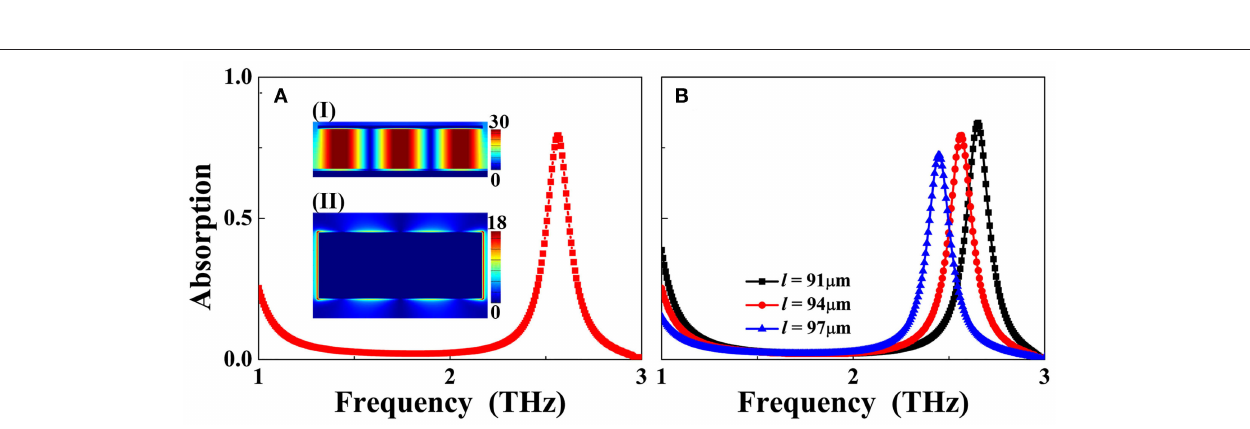
FIGURE 2 | (A) Absorption response of the single-band metamaterial absorber, of which the insets (I) and (II) are, respectively, the electric and magnetic field patterns of the maximum absorption peak at 2.57 THz; (B) Dependence of the absorption response on the length ( l ) change of the rectangular patch resonator.